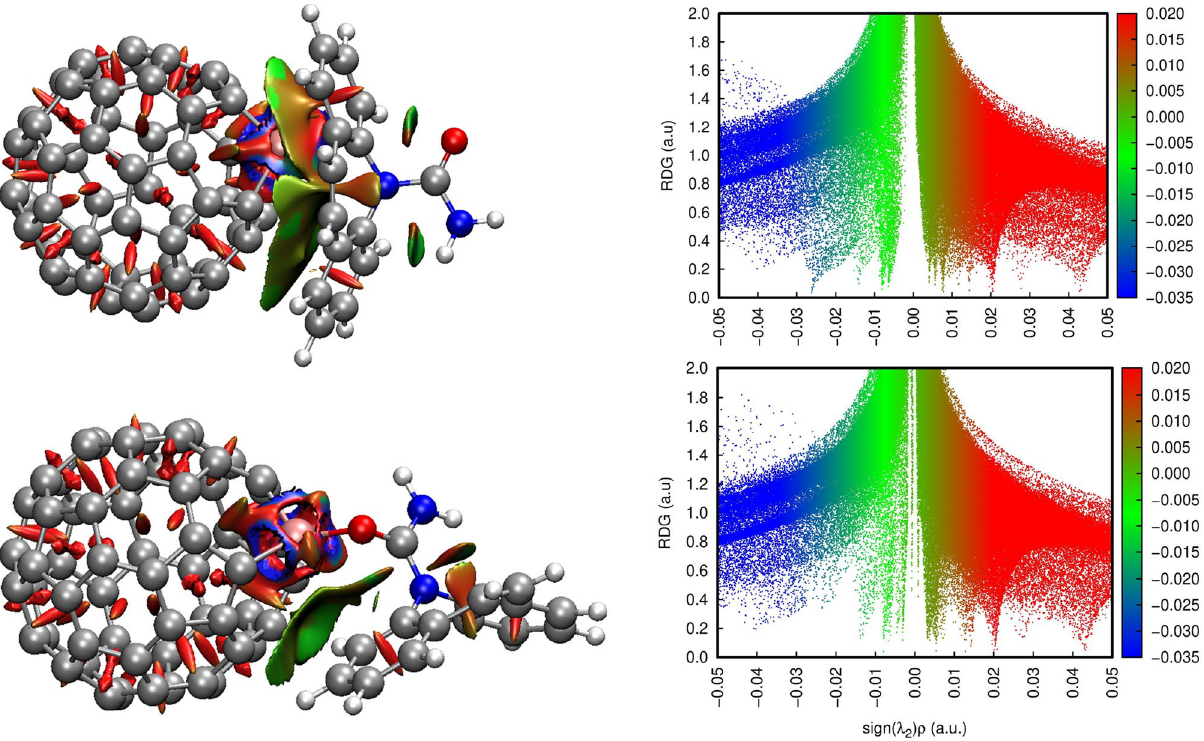
Figure 4. RDG isosurfaces and scatter graphs for C 59 Al-CBZ (I) (top) and C 59 Al-CBZ (II) (bottom). Red- colored regions indicate a repulsive force, green-colored regions indicated van der Waals interactions and blue- colored regions indicated strong attractive non-covalent